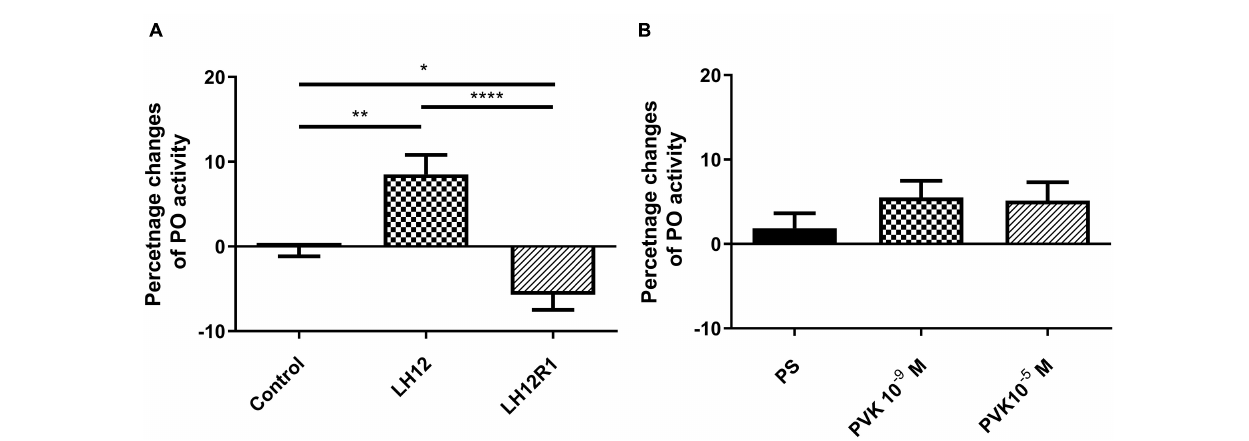
FIGURE 5 | Changes of phenoloxidase activity in the hemolymph of N. vespilloides compared to untreated individuals (control) or beetles injected with physiological saline (PS). (A) LH12: beetles exposed to low humidity for 12 h and LH12R1: beetles exposed to low humidity and recovered for 1 h; PVK 10 − 9 M and PVK 10 − 5 M: